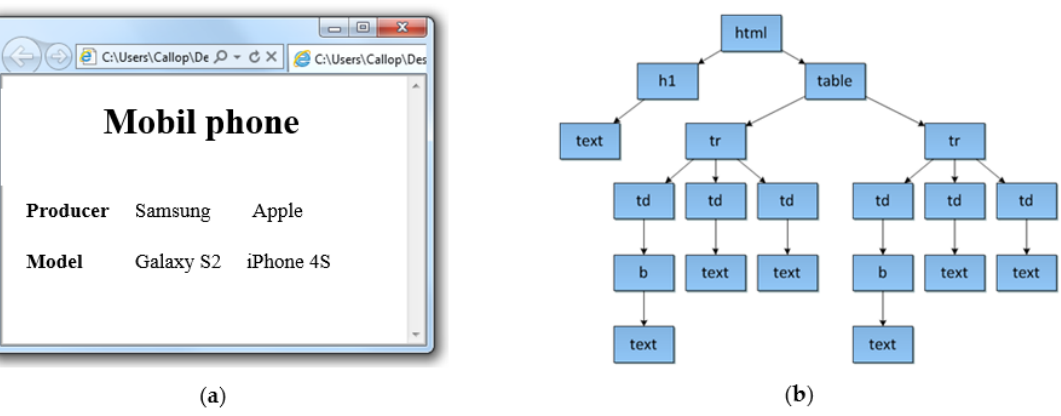
Figure 2. The example of representation of the source code by: ( a ) a web browser; ( b ) DOM tree structure.